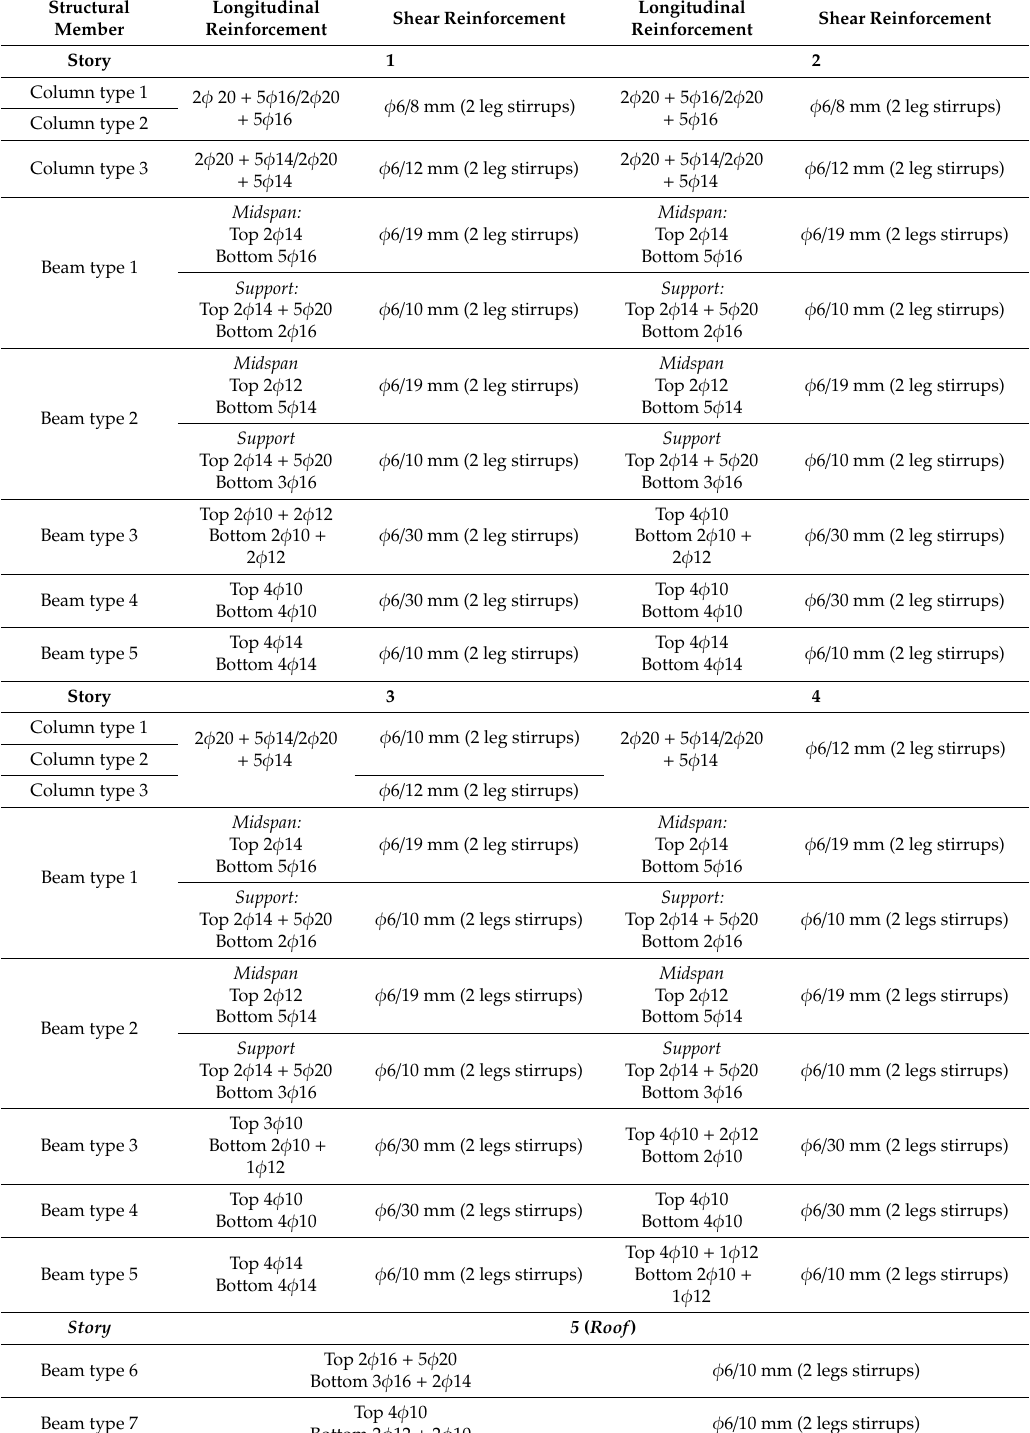
Table 1. Details of the reinforcements for the di ff erent structural